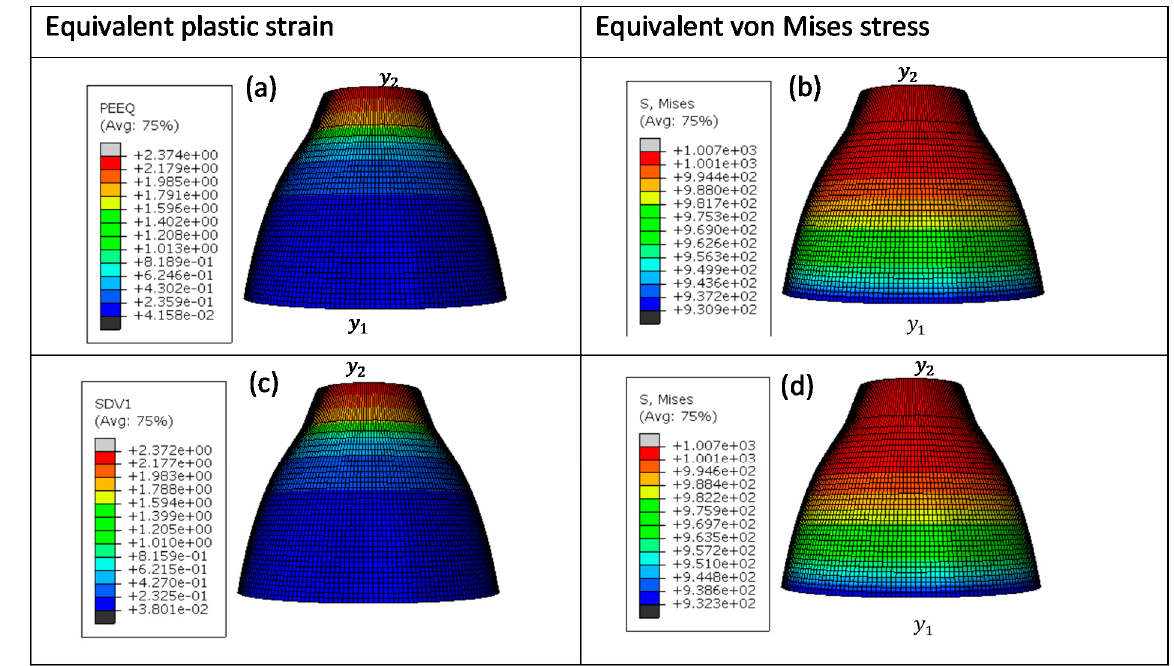
Figure 16. Numerical estimation of ( a , c ) equivalent plastic strain and ( b , d ) equivalent von Mises stress distribution in ( a , b ) VUHARD and ( c , d ) VUMAT subroutines developed here, using 0.25 mm mesh size, at a test velocity of 4 m/s and temperature of 298 K.